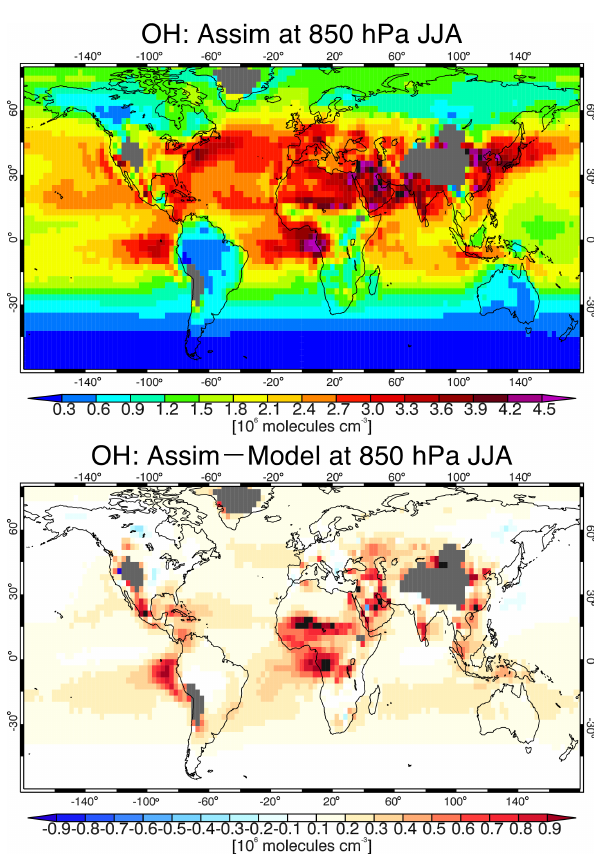
Figure 13. Global distribution of the 10-year mean OH concen- tration (in 10 6 moleculescm − 3 ) in the data assimilation run (top panel) and its difference between the data assimilation run and the model simulation (bottom panel) averaged over June, July, and Au- gust over the 2005–2014 period at 850hPa.